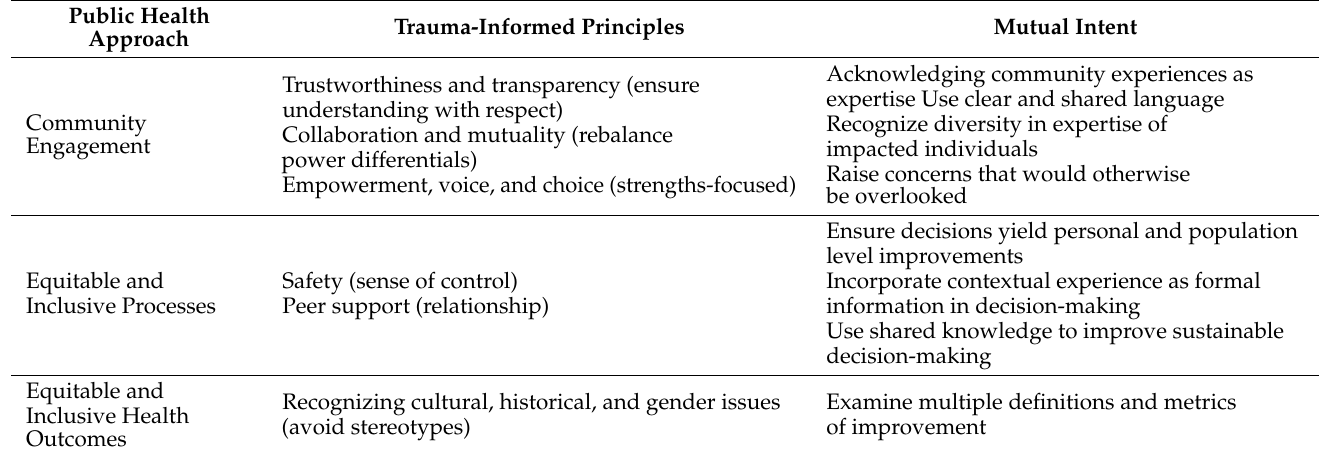
Table 1. Connecting Public Health Approaches with Trauma-Informed